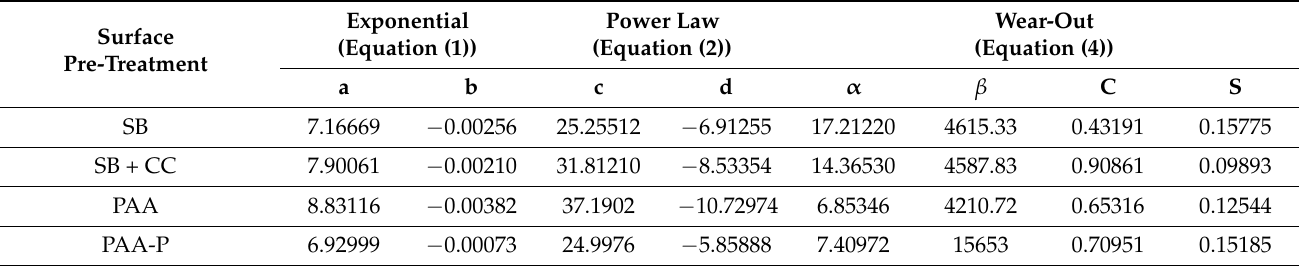
Table A1. Estimated parameters for the selected fatigue